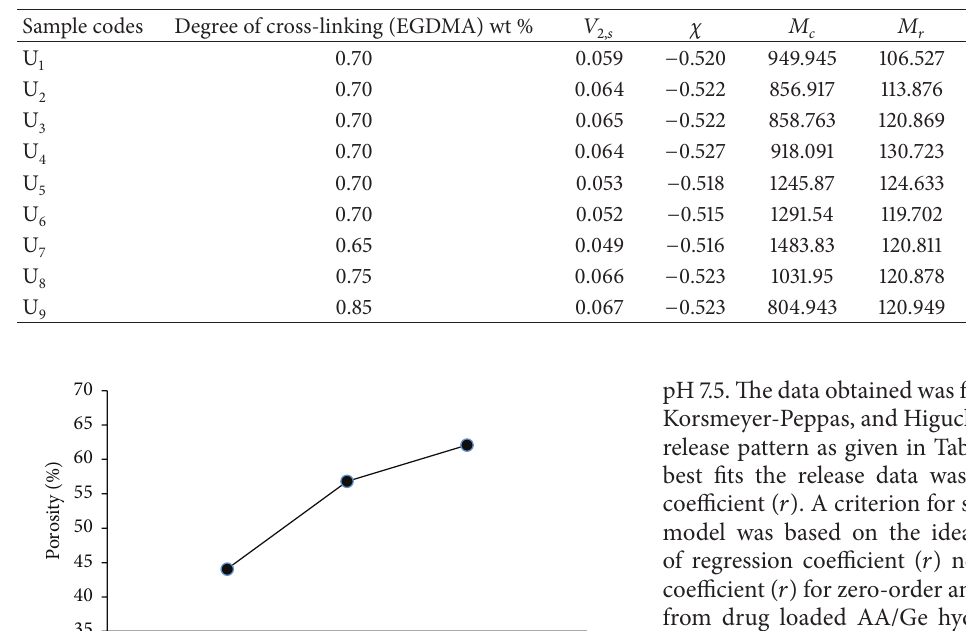
Table 5: Flory-Huggins network parameters of AA/Gelatin hydrogel.